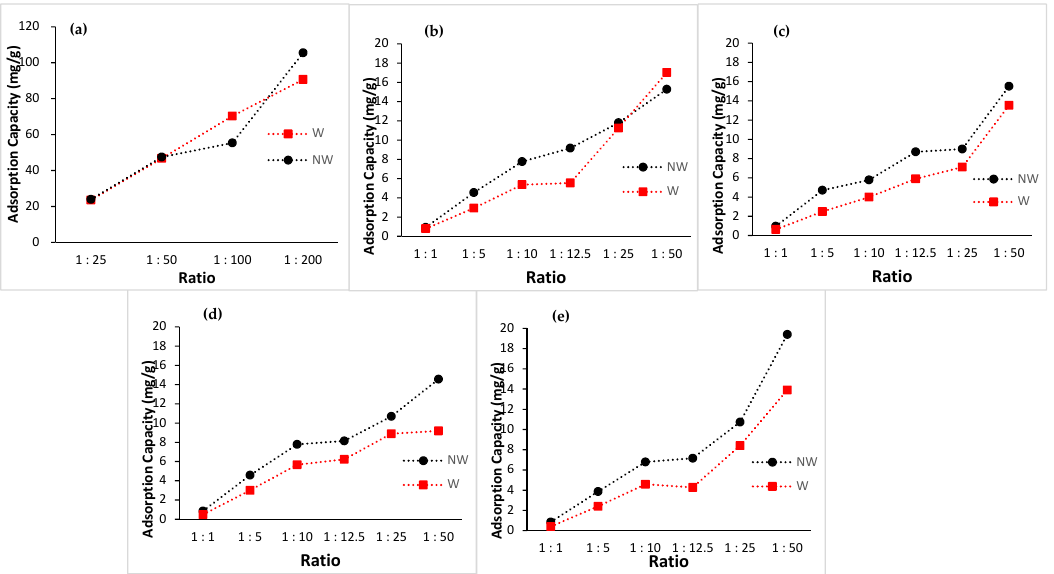
Figure 4. Adsorption capacity under different ratio at 48 h for not washed and washed digestate adsorbent removal of various dyes. ( a ) MB; ( b ) DY27; ( c ) AR66; ( d ) RV5; ( e ) RB5.